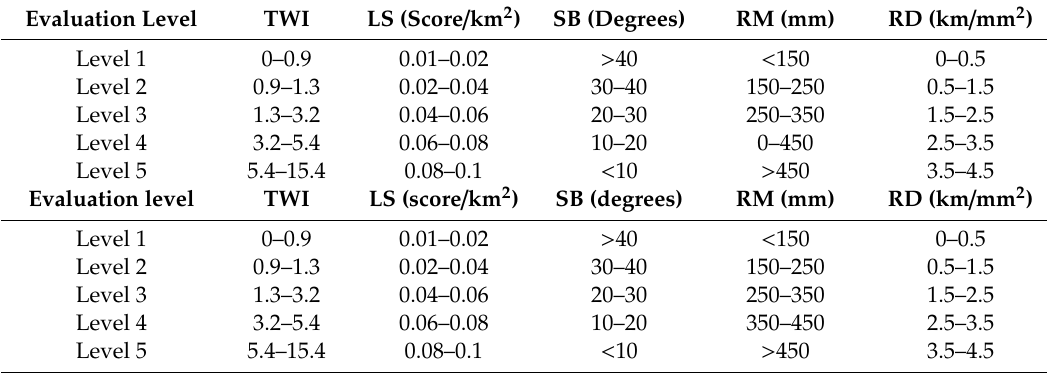
Table 3. Flash flood risk evaluation indicators for average rainfall of several years (RM), topographic wetness index (TWI), average slope of tributary (SB), landslide density (LS) and river density (RD) information layers.